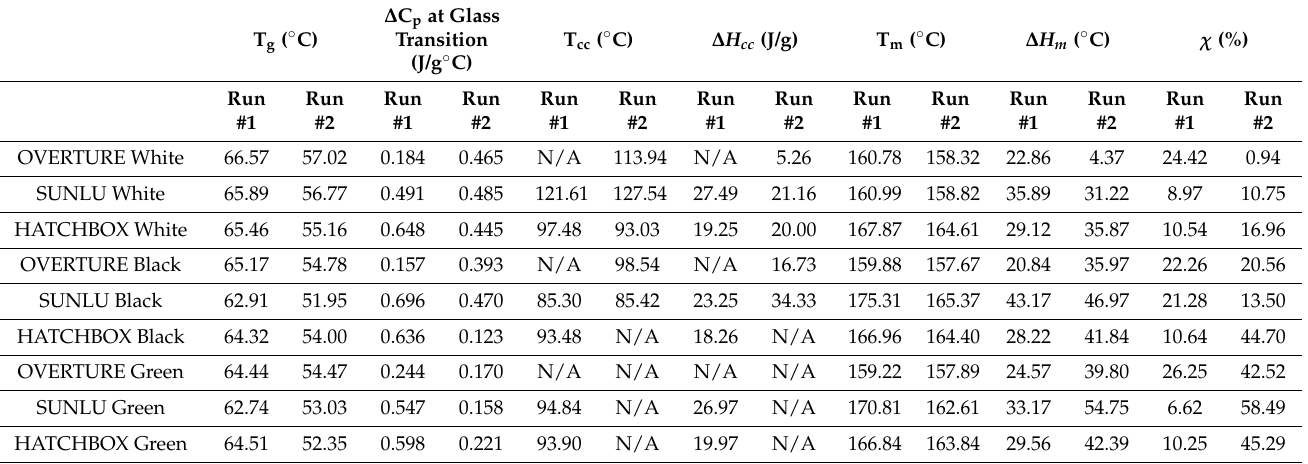
Table 6. Extracted values from the DSC Runs #1 and #2 for all nine filaments, where “N/A” indicates that no value was measured for the given